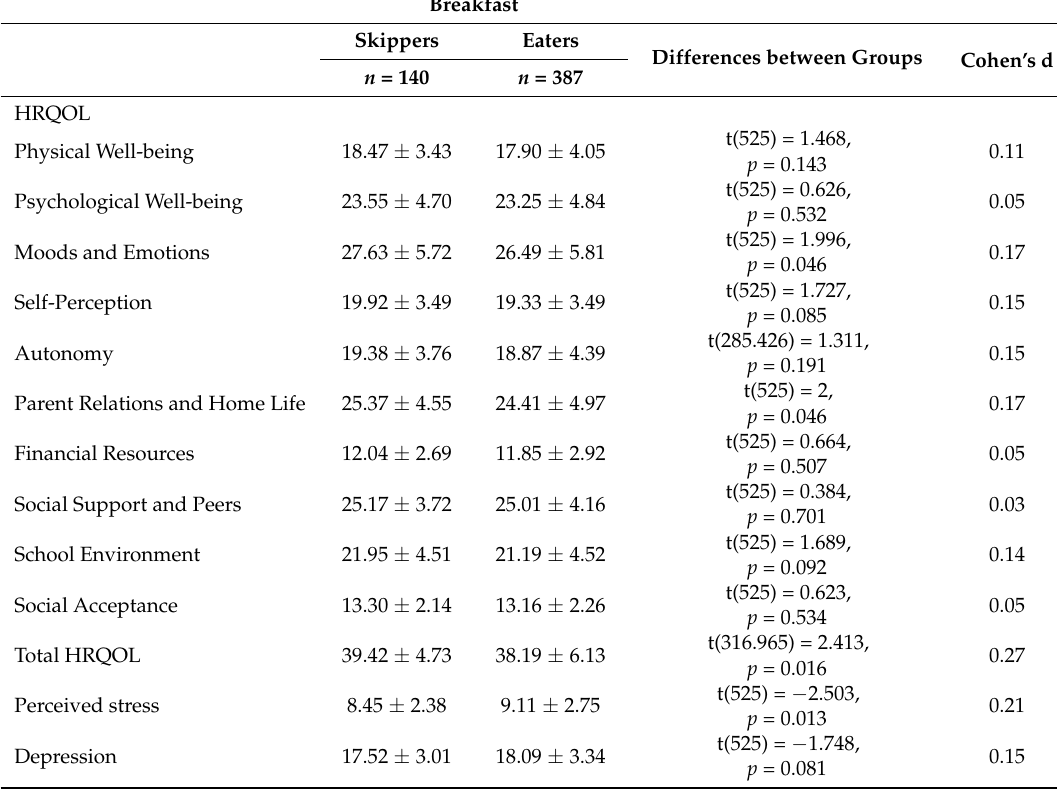
Table 1. Differences between breakfast skippers and breakfast eaters in health-related quality of life (HRQOL), perceived stress and depression. Breakfast Skippers Eaters Differences between Groups Cohen’s d n = 140 n =